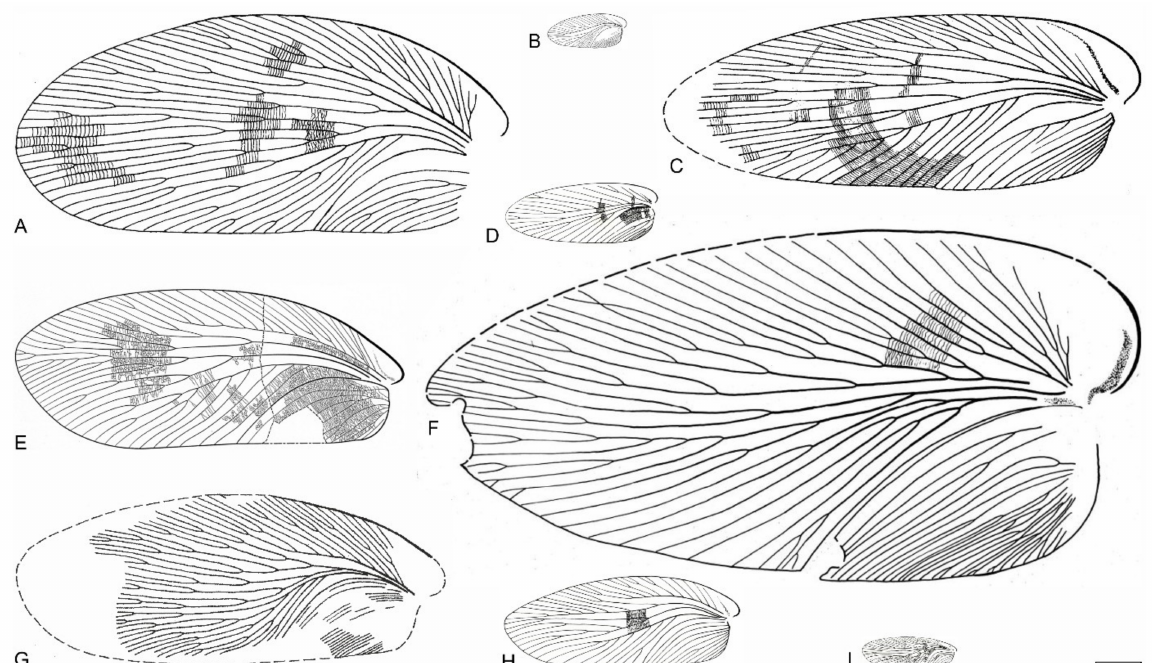
Figure 20. Examples of largest and smallest blattoids of the Late Paleozoic; scale bar: 5 mm; ( A )— Progonoblattina helvetica (Heer, 1864), late Moscovian, length 51 mm, MfNC F15186; ( B )— Poroblattina parvula (Goldenberg, 1869), Kasimovian to Asselian, length 8.5 mm, MH 157a,b; ( C )— Necymylacris heros Scudder, 1879, late Moscovian, length 50 mm, USNM 201064; ( D )— Moravamylacris kukalovae Schneider, 1980, Sakmarian to ?Artinskian, length 16 mm, KUP 13; ( E )— Anthracoblattina Scudder, 1879, Kasimovian to Sakmarian, length 40 mm, CDUE TaI-13d-25; ( F )— Opsiomylacris sp., Schulz et al., (2013), Gzhelian, length 75 mm, KUMIP 15311; ( G )— Aissoblatta sp., undescribed, Lopingian, length 45 mm, FG 699-1; ( H )— Phyloblatta occidentalis (Scudder, 1890), Kasimovian to Gzhelian, length 25 mm, type specimen to Etoblattina parva Meunier, 1921, MNHN-F-R51101; ( I )— Phyloblatta compactiformis Schneider, 1984, Sakmarian to Kungurian, length 10 mm, KUP